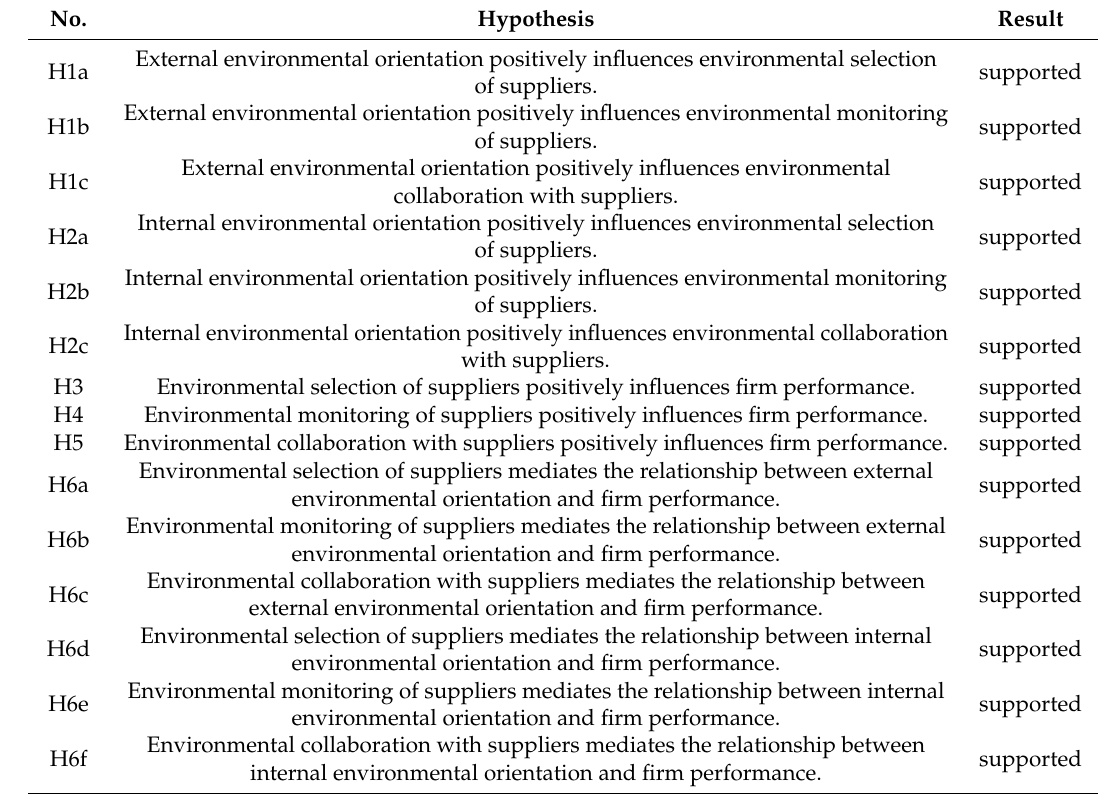
Table 7. Summary of the results of hypotheses